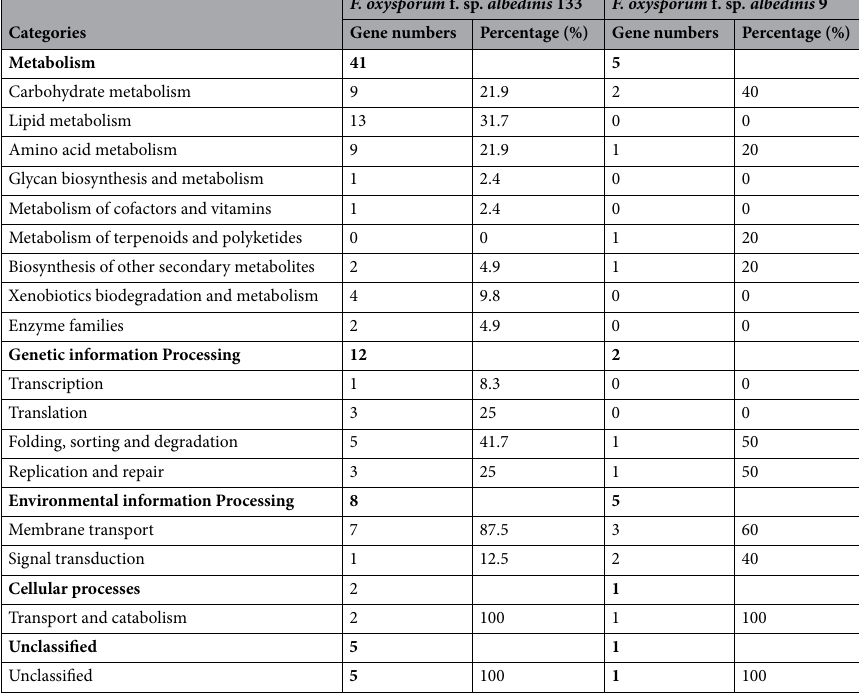
Table 1. KEGG pathways enriched in unique genes of the 133 and 9 Foa strains. Values in bold are significant values, they indicate the total number of unique genes involved in each KEGG pathway